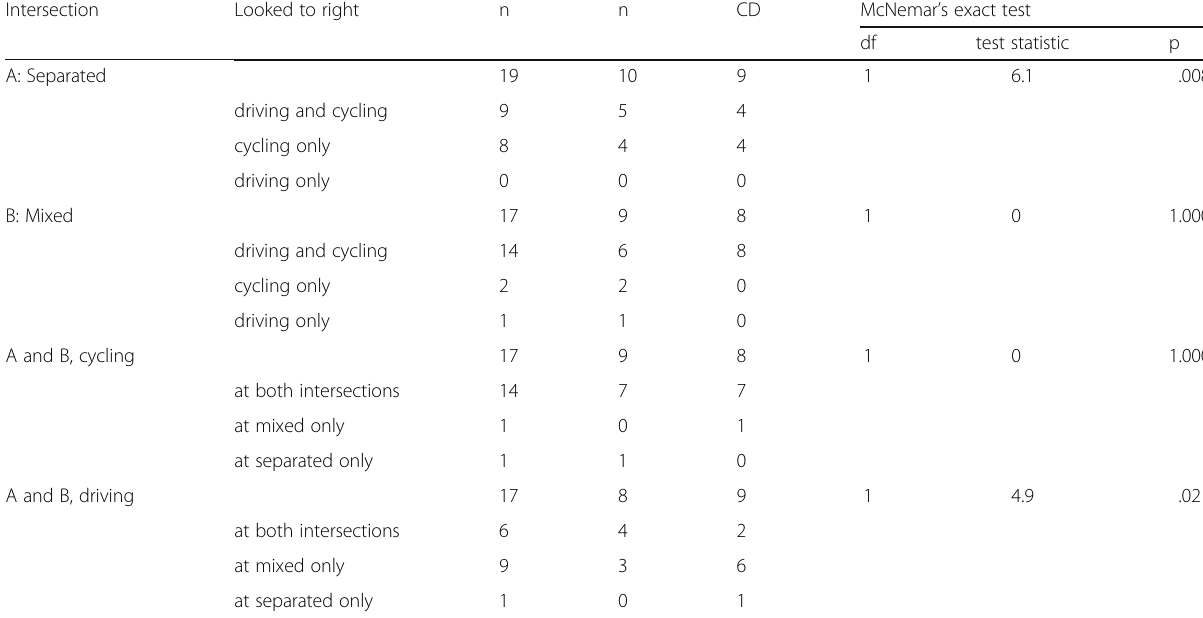
Table 4 Sample sizes (n = total, CC = character cyclists, CD = character drivers) and outcomes of McNemar ’ s tests for the current road-user role. Exclusion criteria: disturbed by traffic in front, no eye tracking, pavement riding. Intersections according to Table 3 Intersection Looked to right n